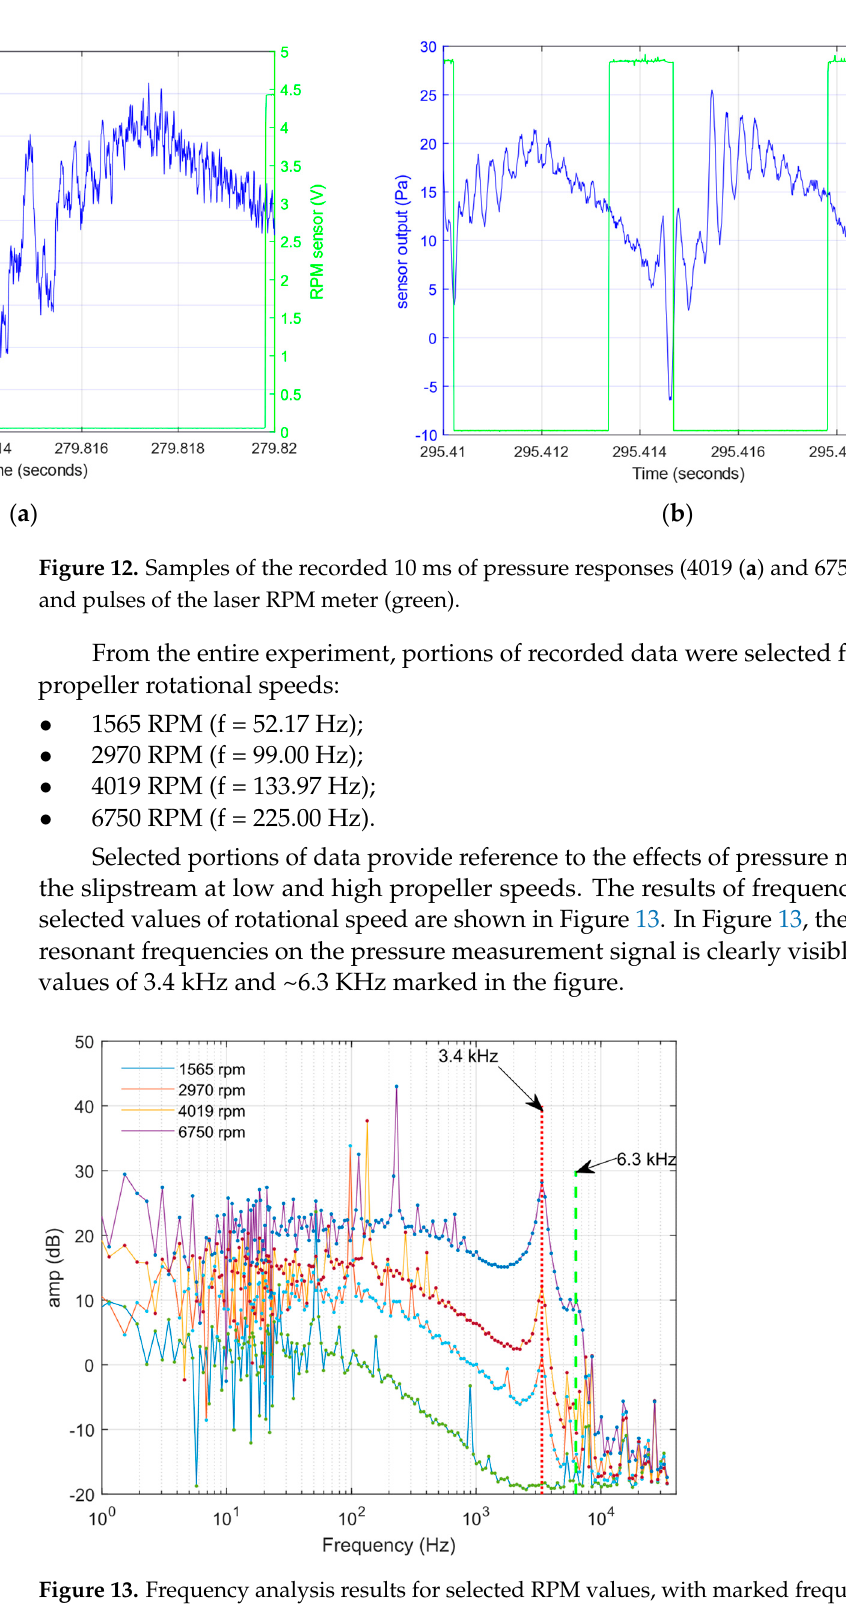
Figure 11. Experiment with RPM changes.